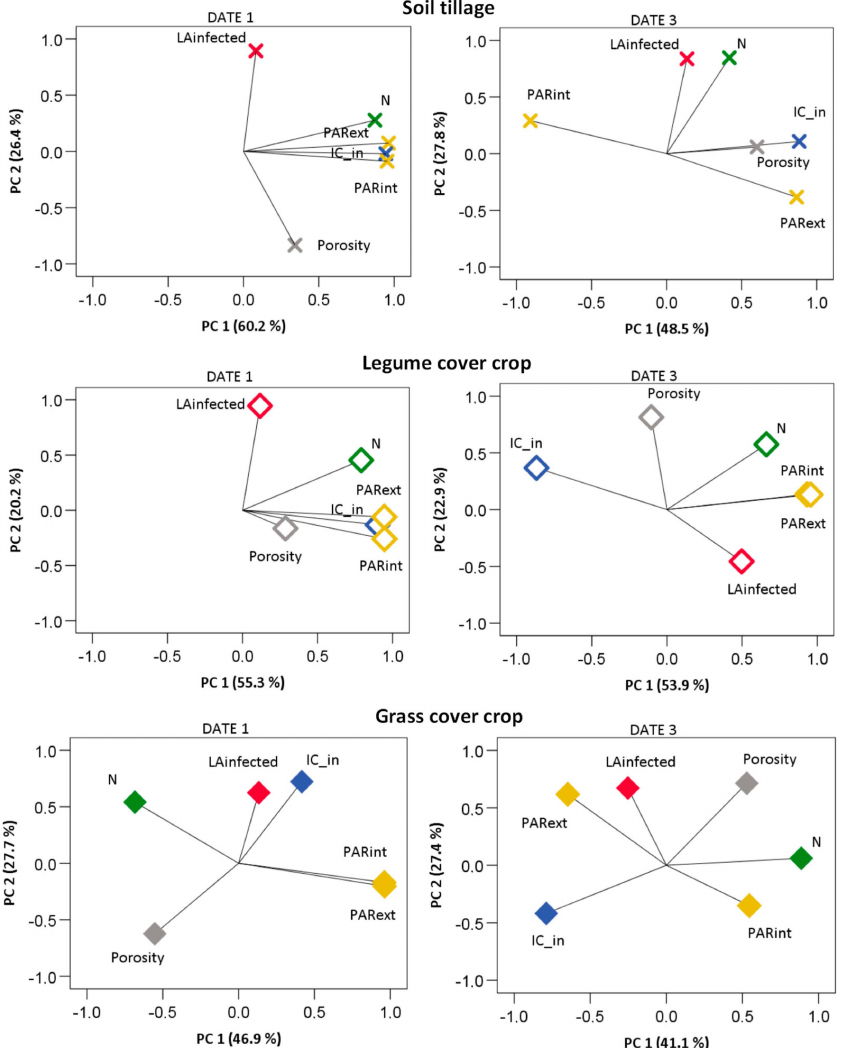
Figure 12. Multifactor analysis score plots of the infected LA per shoot, leaf N, canopy porosity, PAR levels in the external and internal layers, and IC inside the canopy, in each soil management treatment (ST—dark cross, LEG—white rhombus; GRA—dark rhombus) during the grapevine downy mildew observation dates 1 and